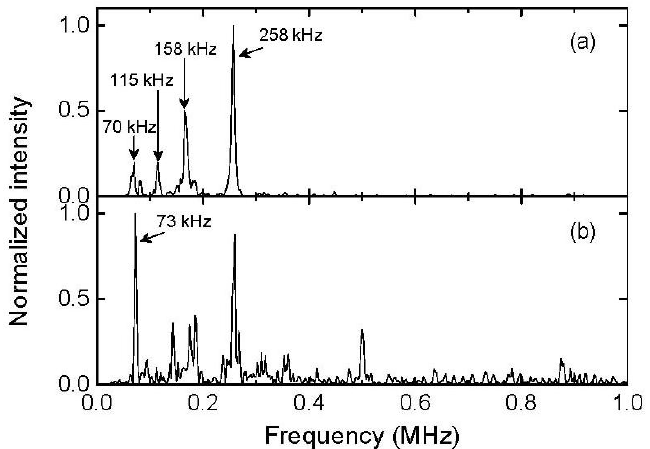
Figure 10. Frequency characteristics of the FBG sensor responses shown in Figure